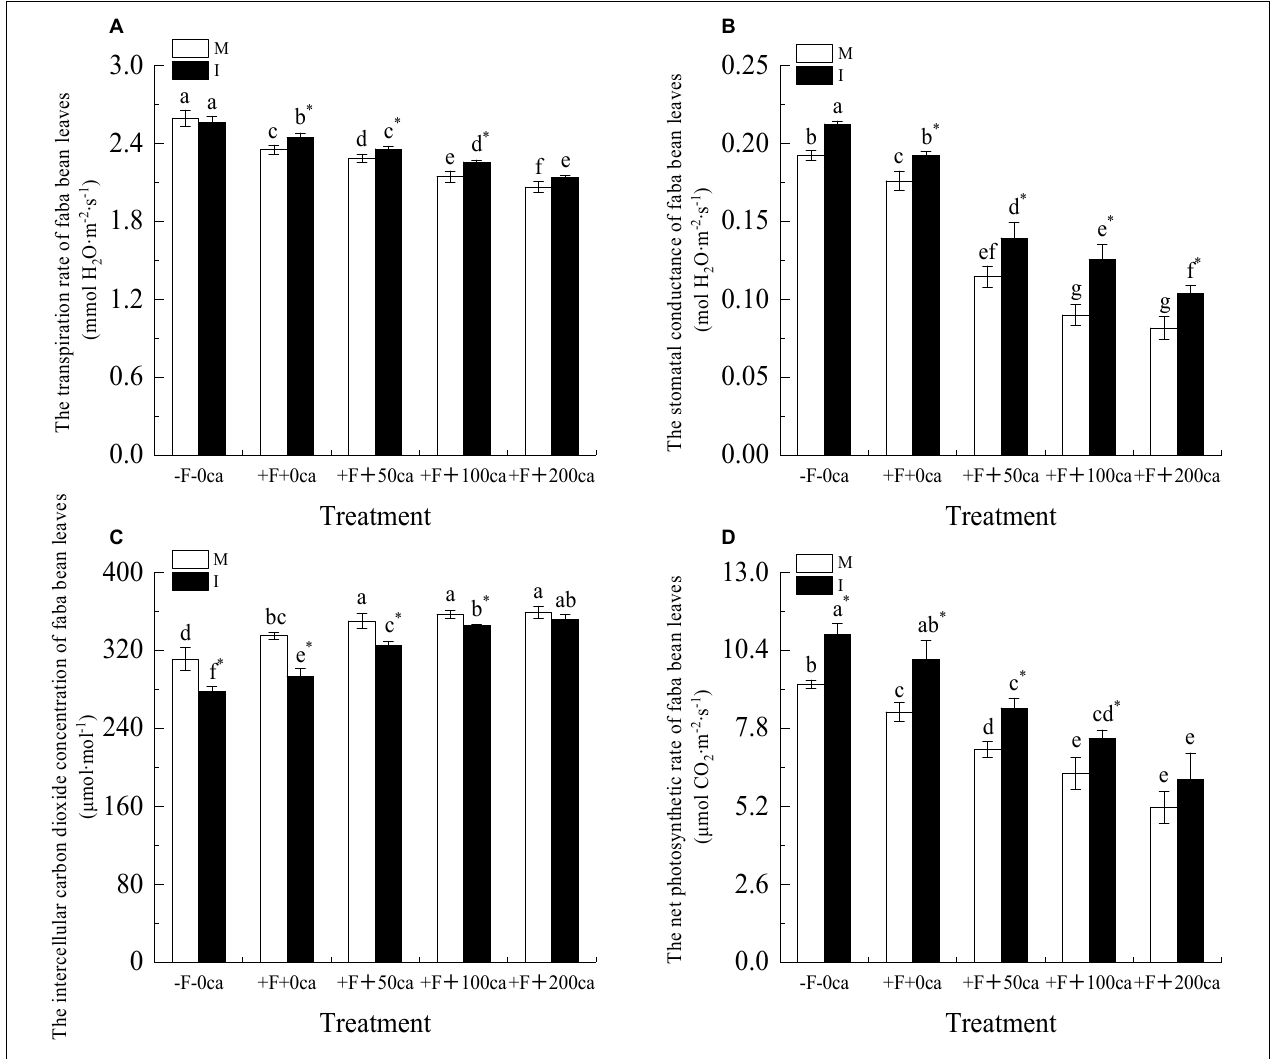
FIGURE 8 | Effects of FOF and cinnamic acid stress on the photosynthesis of faba bean ( Vicia faba ) leaves and intercropping effect. (A) Transpiration rate (T i ), (B) Stomatal conductance (G s ), (C) Intercellular carbon dioxide concentration (C i ), (D) Net photosynthetic rate (P n ). Values in the table are mean ± standard error. Different lowercase letters after data indicate significant differences ( P < 0.05). *Significant differences between monocropping and intercropping treatments with the same FOF and cinnamic acid levels ( P < 0.05). ca, cinnamic acid; FOF, Fusarium oxysporum f. sp. pisi ; I, intercropping; M, monocropping.